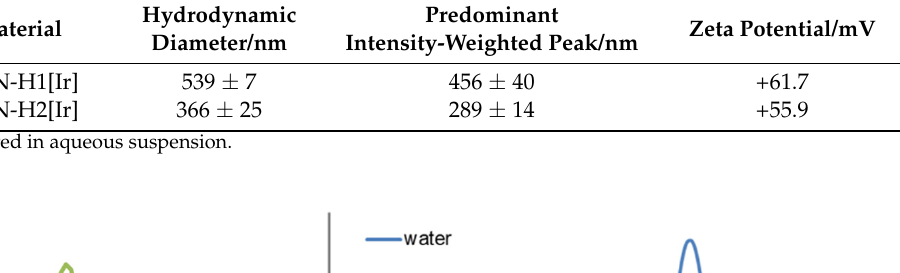
Table 1. Hydrodynamic radius and zeta potential of prepared nanomaterials *.